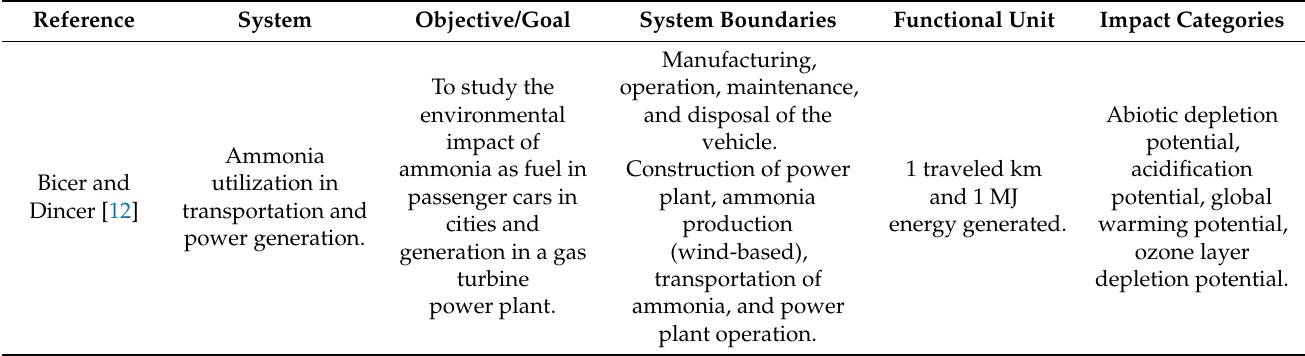
Table 1. Life cycle assessment studies of ammonia-based